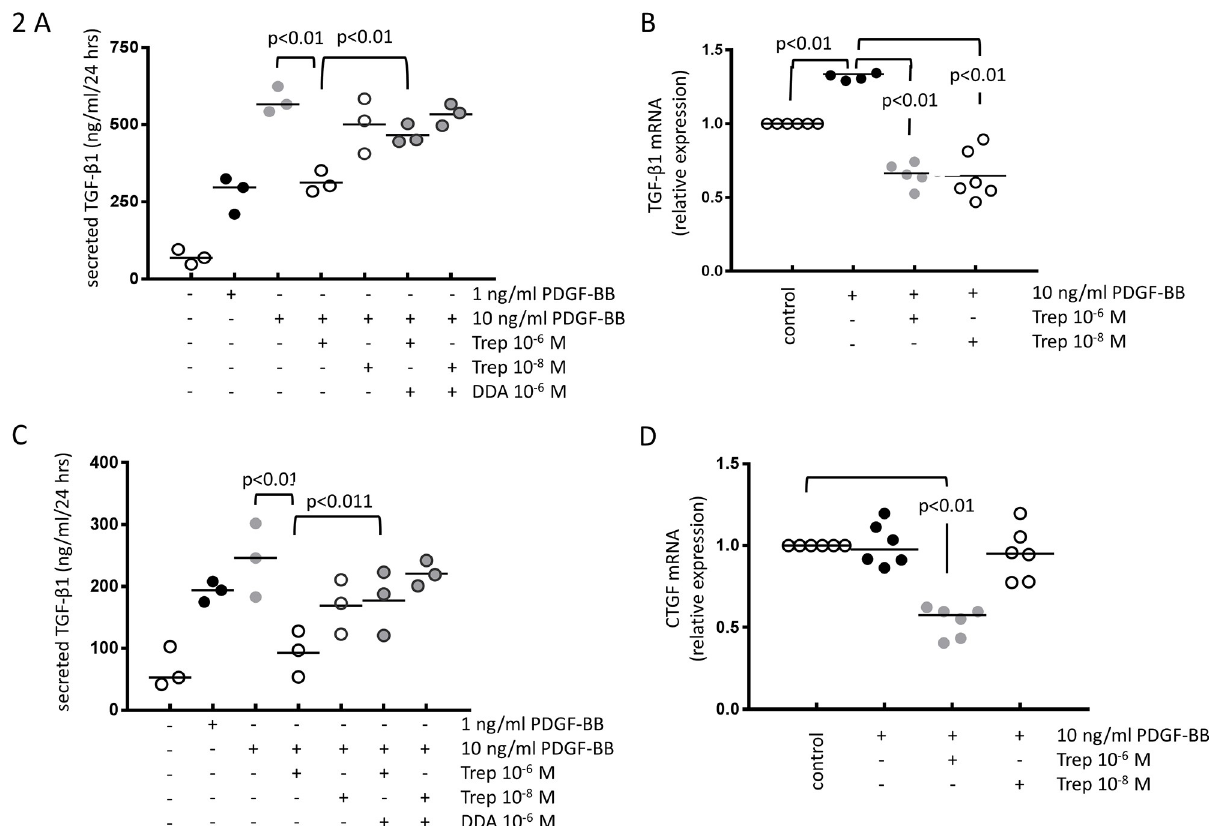
Fig 2. (A) The inhibitory effect of treprostinil on the de novo synthesis of TGF- β 1 on the level of protein secretion (n = 3) and (B) mRNA synthesis (n = 6). The inhibitory effect of treprostinil on (C) CTGF secretion (n = 3) and (D) CTGF mRNA synthesis (n = 6).